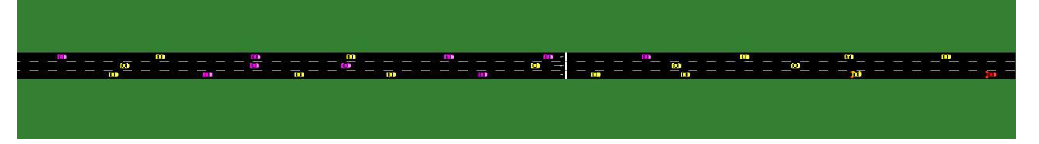
Figure 11. Simulation of Urban Mobility (SUMO) scenario.